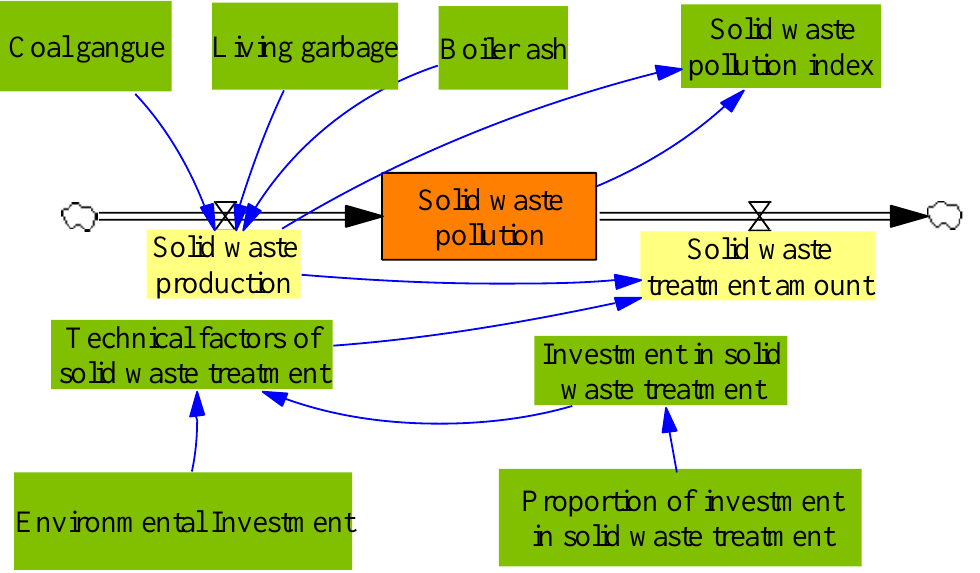
Figure 3. The system flow diagram of solid waste subsystem.